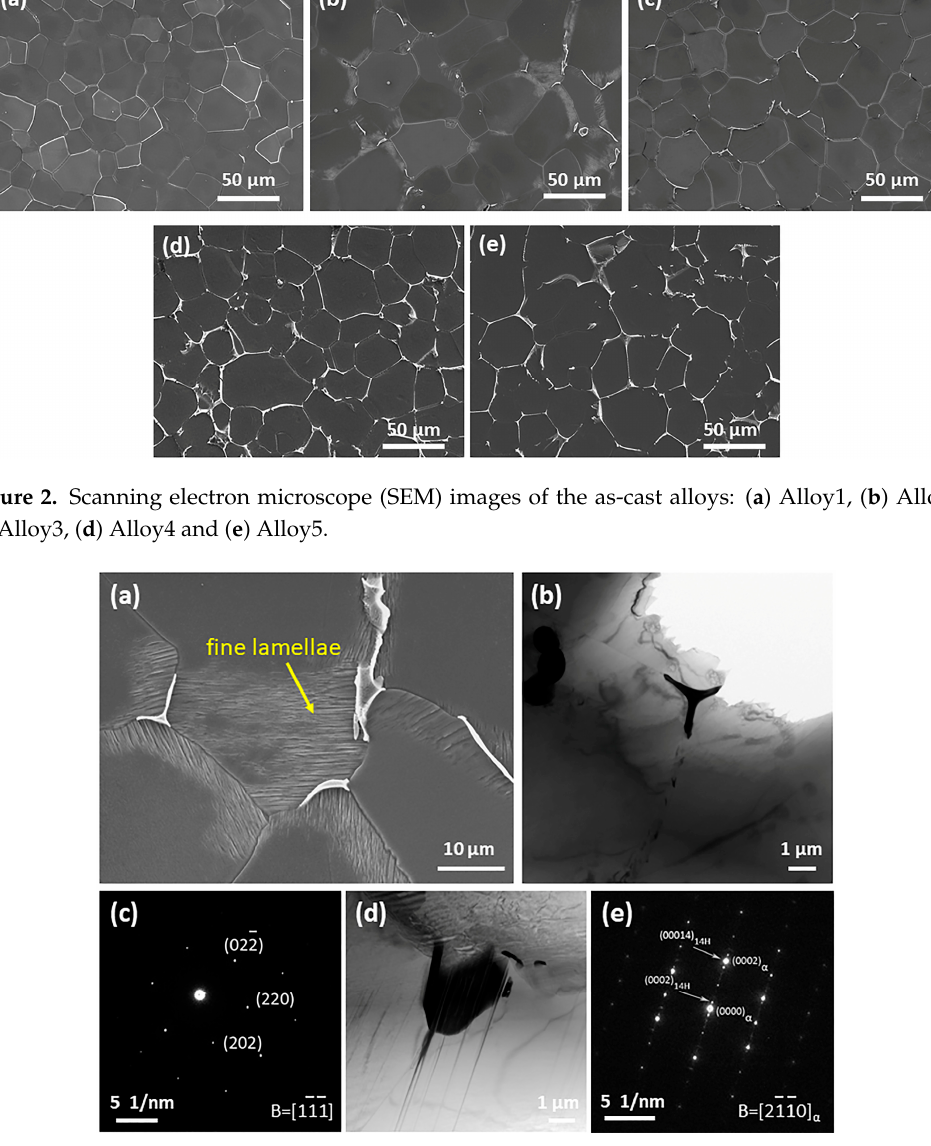
Figure 3. Micrographs of as-cast Alloy2: ( a ) SEM image, ( b , d ) Bright field transmission electron microscope (BF TEM) images and ( c , e ) their corresponding selected area electron diffraction (SAED)